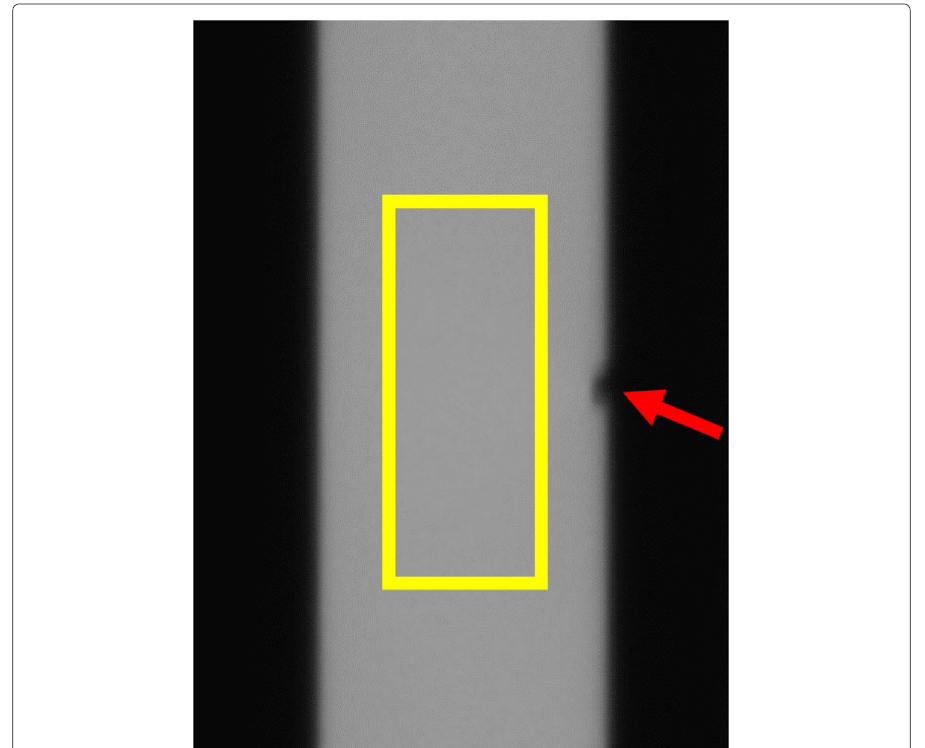
Fig. 5 An example of the raw data is shown. It is an image of the tungsten-strip of the calibration lamp. The calibrated region is schematically shown with the rectangular box. The position of the calibrated region can be found using the notch